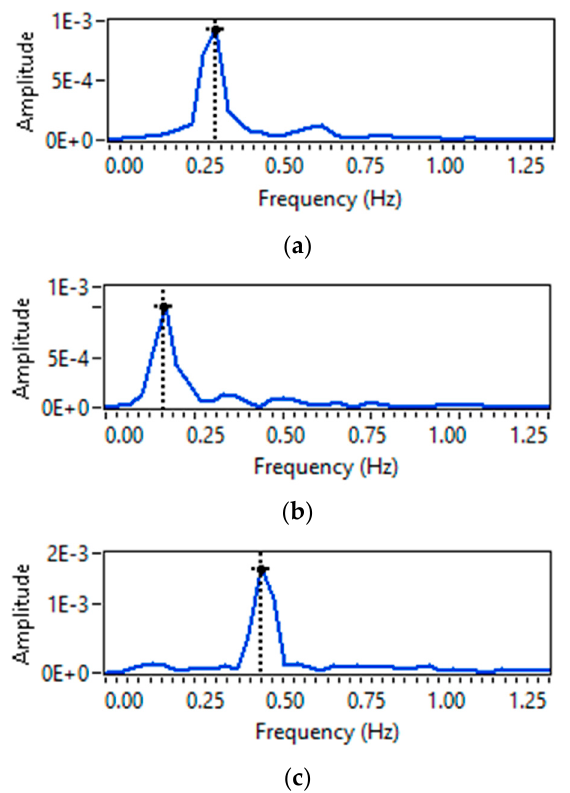
Figure 9. Breathing rate extraction for one person-scenario: ( a ) normal breathing; ( b ) slow breathing; and ( c ) fast breathing.